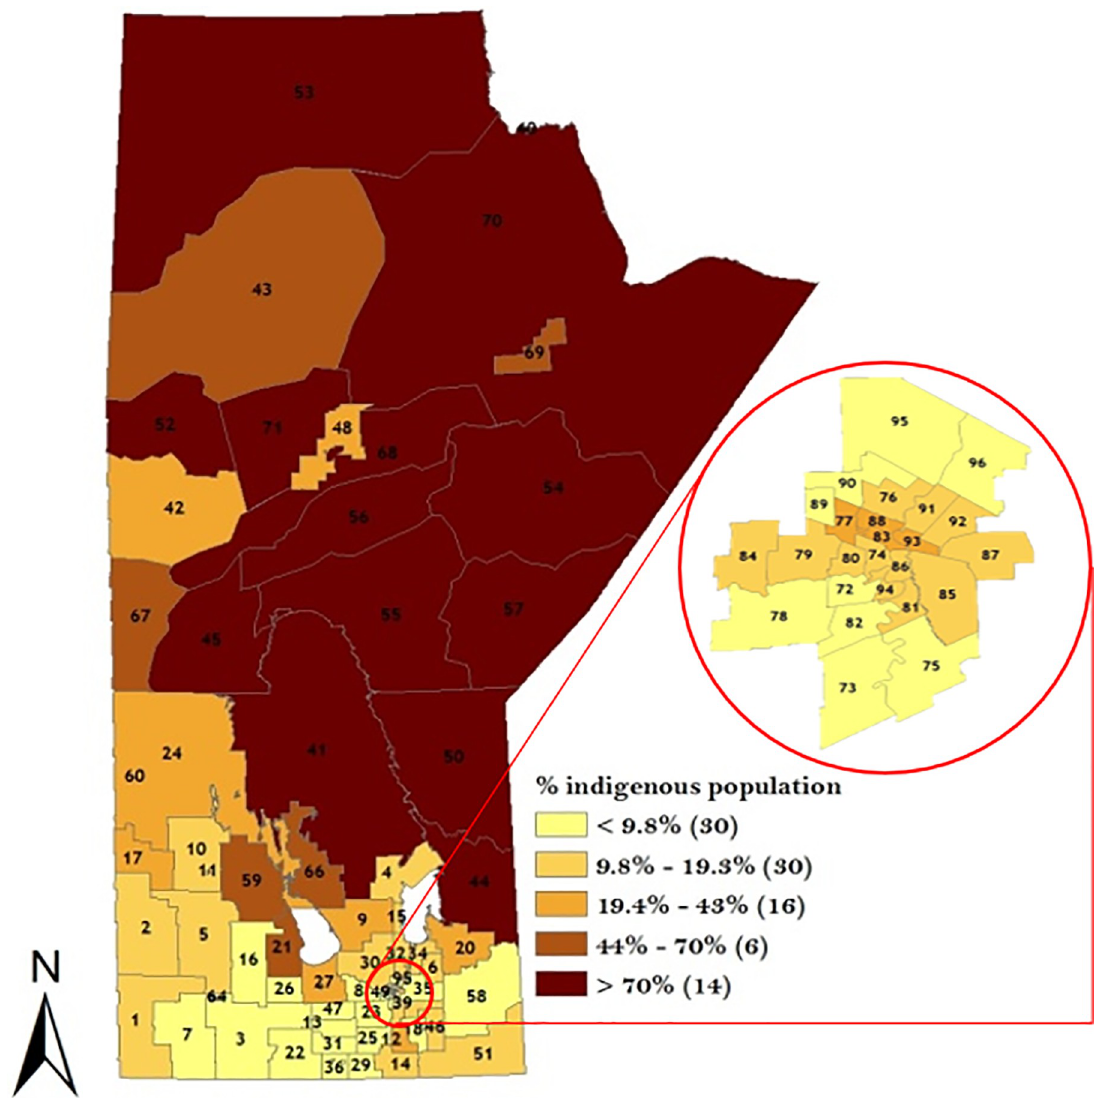
Fig 3. Geographical distribution of Indigenous population across the 96 RHADs based on 2016 Canadian Census data. Numbers in the map are the district labels from 1 to 96. Values in parenthesis represents the counts in each distribution category.